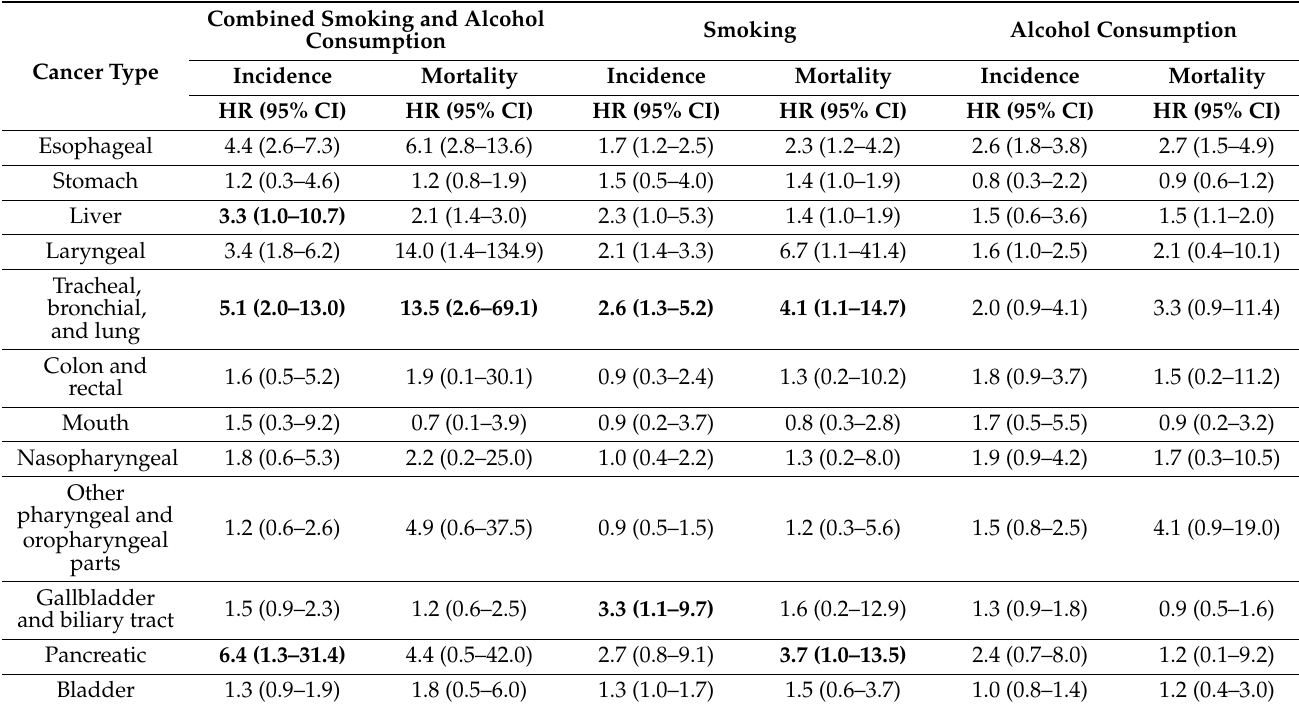
Table 3. Cancer type-specific incidence and mortality rates stratified by smoking and alcohol con- sumption in Korean